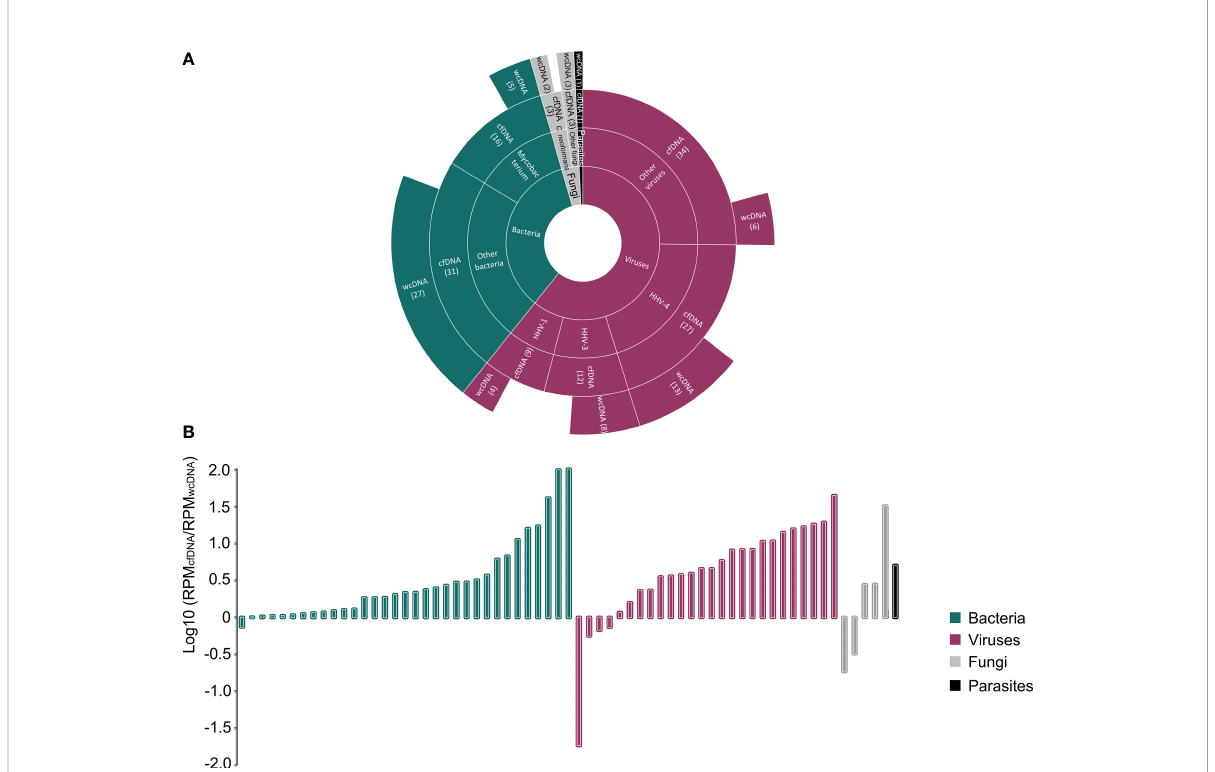
FIGURE 2 Comparison between the mNGS of cfDNA and wcDNA. (A) , Summaries of case numbers by detected pathogens, including bacteria, viruses, fungi, and parasites. The mNGS of cfDNA detected more viral and mycobacterial infections than the mNGS of wcDNA. (B) , Difference in the number of detected RPMs for the same pathogen between the mNGS of cfDNA and wcDNA. The value of >0 represents that the number of detected RPMs by the mNGS of cfDNA is higher than that by the mNGS of